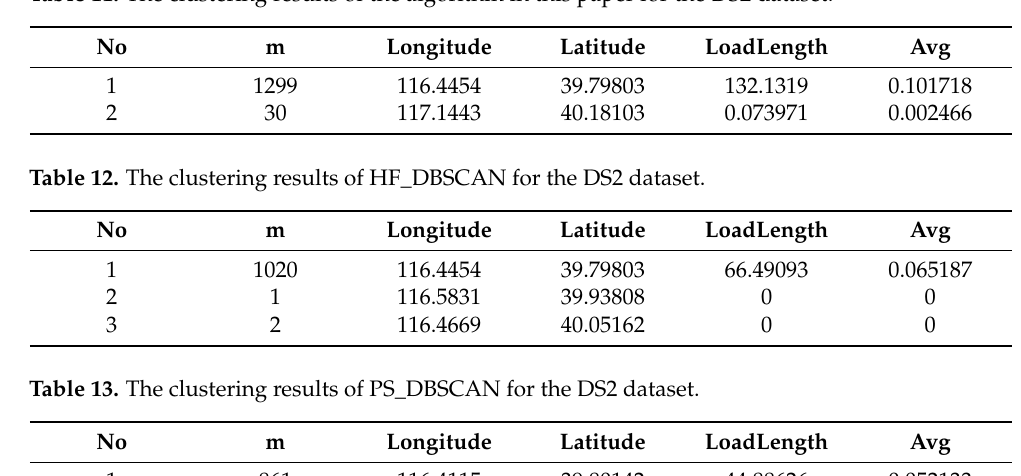
Table 11. The clustering results of the algorithm in this paper for the DS2 dataset.